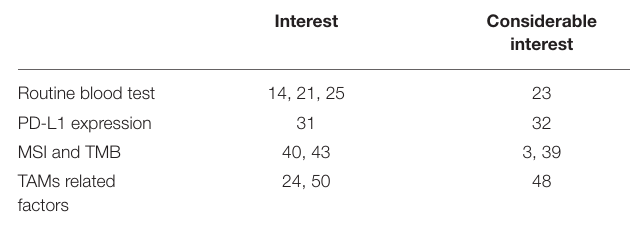
TABLE 1 | Highlighted papers in each